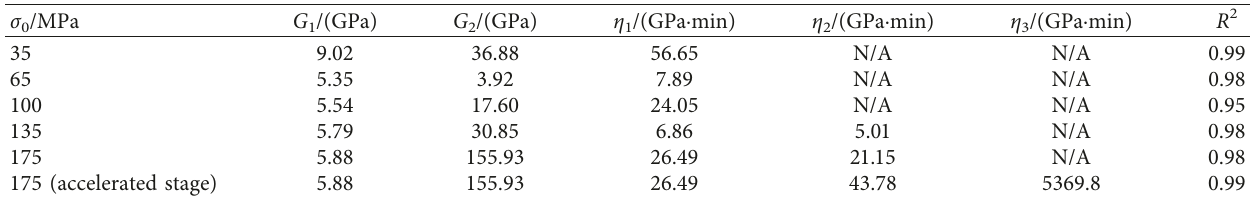
Table 3: Model fitting parameters ( σ